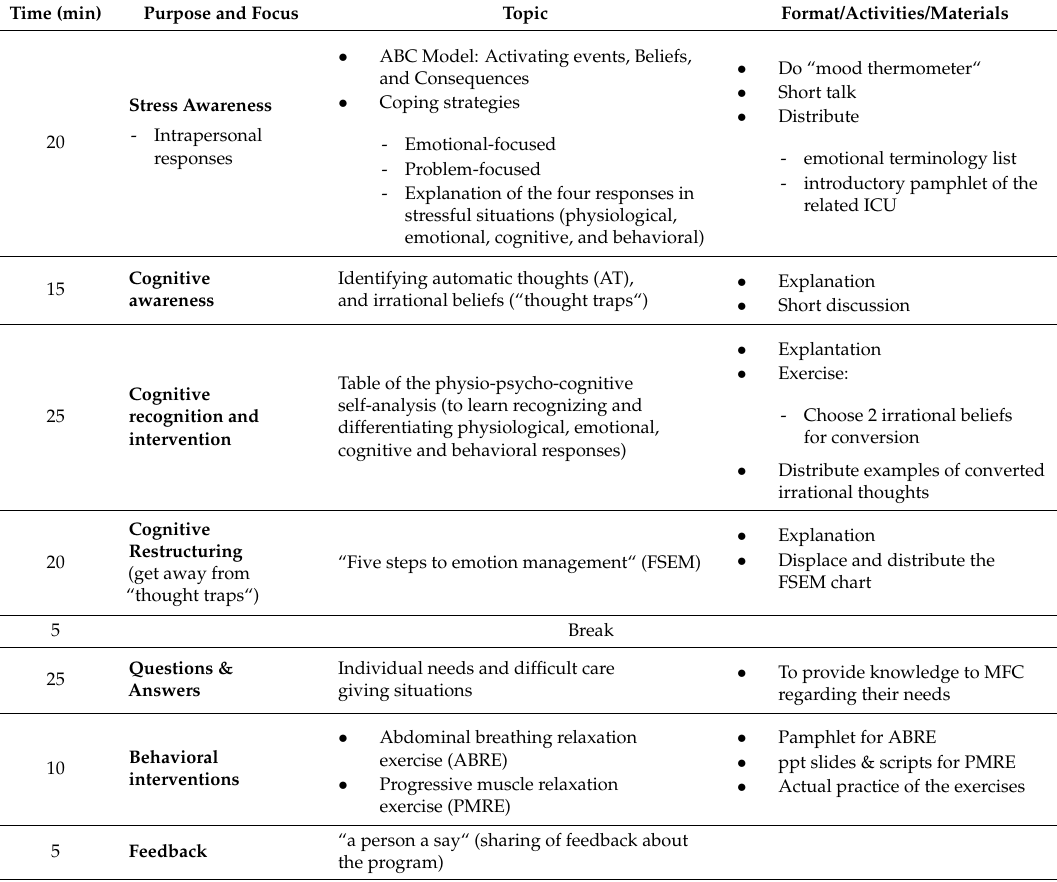
Table 1. The brief cognitive-behavioral education program (B-CBE) for main family caregivers (MFCs) of patients in the intensive care unit